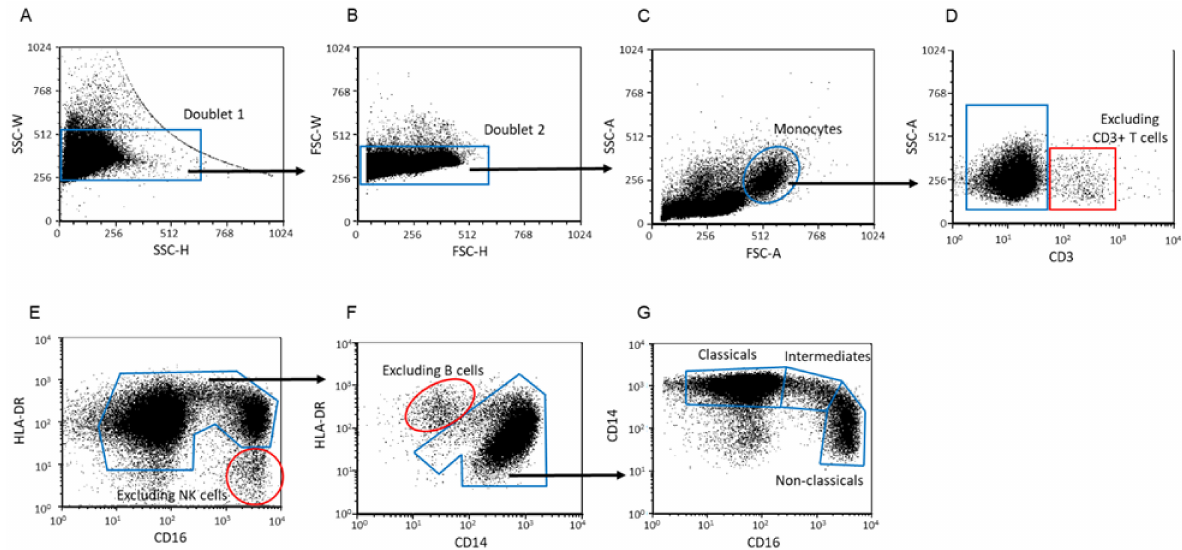
Figure 7. Gating strategy to detect monocyte subpopulations. The gating technique was used to determined monocyte subpopulations from peripheral blood mononuclear cells. After a two-step doublet exclusion ( A , B ), the monocyte population was gated using FSC-A/SSC-A parameters ( C ). From roughly gated monocytes, the CD3+ cell population was excluded ( D ). CD16 vs. HLA-DR dot plot: CD16+/HLA-DR − NK cells could exclude from the monocytes ( E ). CD14 vs. HLA-DR dot plot: HLA-DR high/CD14 low B cells could exclude from the monocytes ( F ). Using CD16 and CD14 markers, monocytes were gated based on their characteristic “